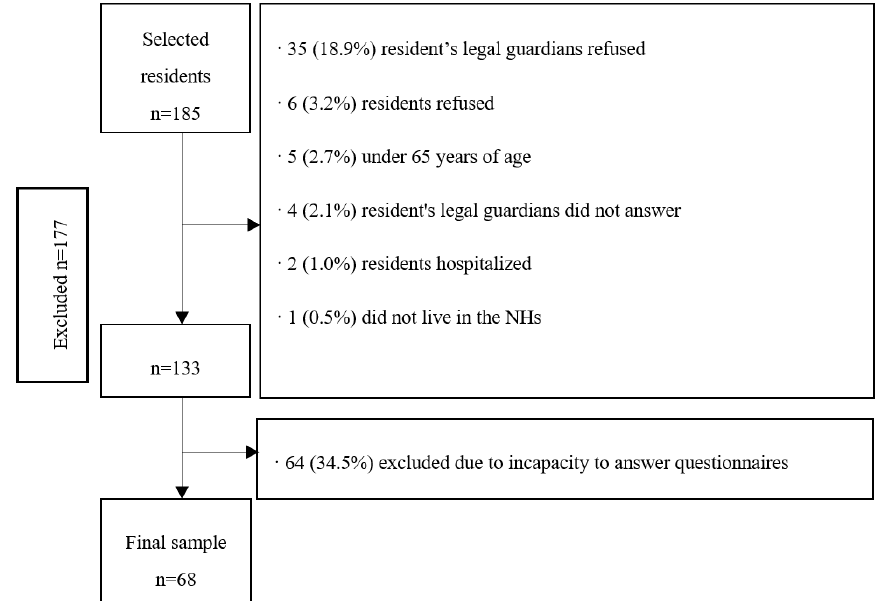
Figure 1. Flow chart of the sampling process of nursing home (NH) residents with capacity to answer questionnaires (Osona, Spain, 2020).